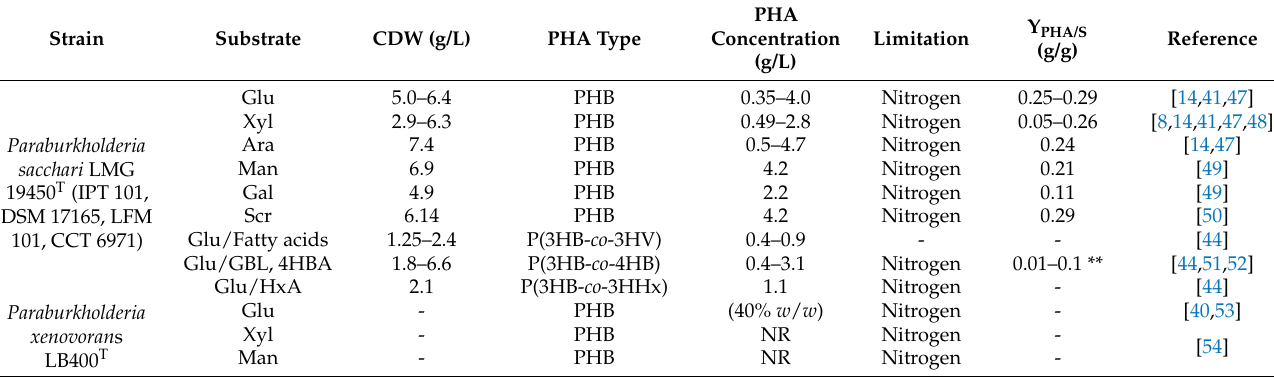
Table 1. PHA homopolymers and copolymers synthesized by Paraburkholderia and Burkholderia strains. Strain Substrate CDW (g/L) PHA Type